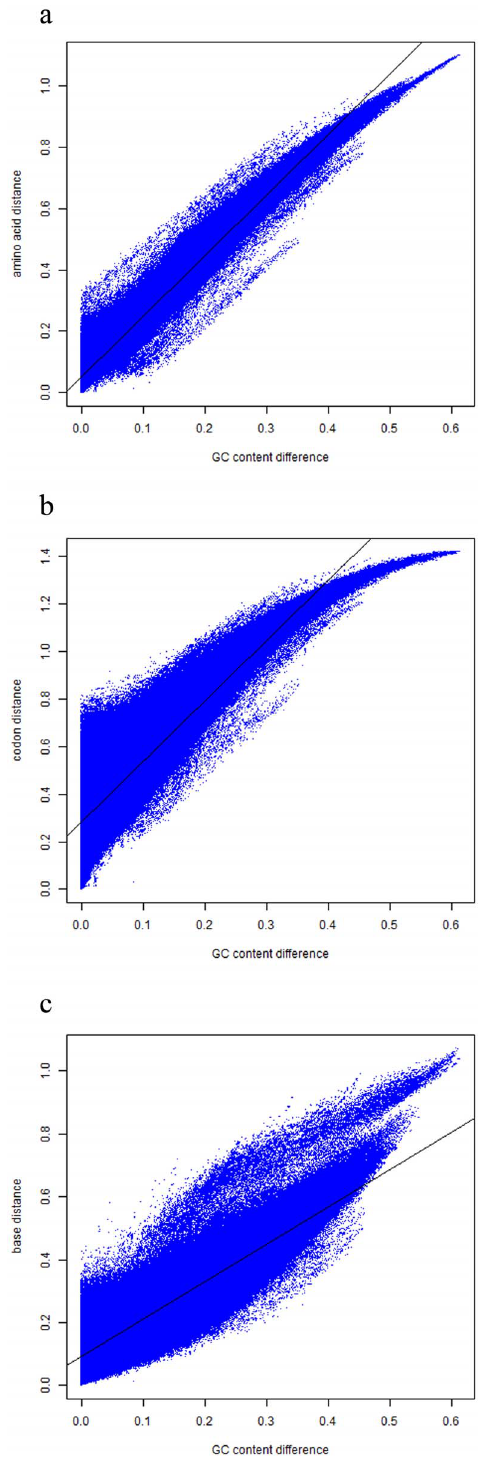
Figure 1. Base, codon, and amino acid frequency-based heat maps. The x-axis and y-axis represent 2670 prokaryotic genomes with GC content arranged from smallest to largest. a) Base frequency-based heat map; maximum base distance=1.0986. b) Codon frequency-based heat map; maximum codon distance=1.4199. c) Amino acid frequency- based heat map; maximum amino acid distance=1.0725.